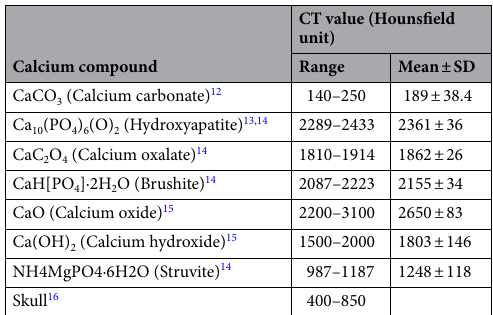
Table 1. CT values of calcium compounds in the human body 12–16